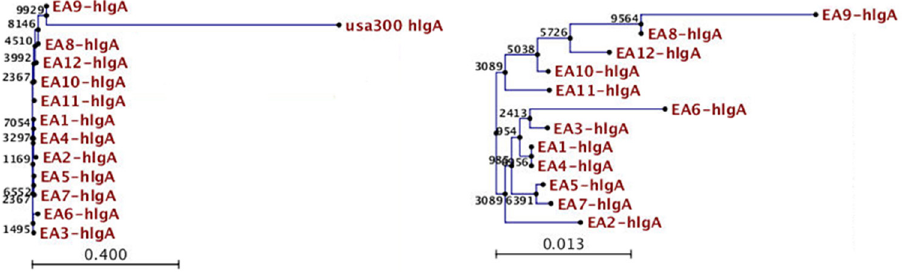
Fig 1. Dendrogram of the differences between study isolates (EA1 through EA12) and the USA 300 reference strain at the gamma hemolysin subunit (HlgA) (left) and dendrogram of the polymorphisms of the gamma hemolysin subunit of the study isolates (right). The tree was generated by neighbor joining analysis with a bootstrap of 10,000. The numbers refer to the confidence of related associations. Higher numbers indicate greater confidence.